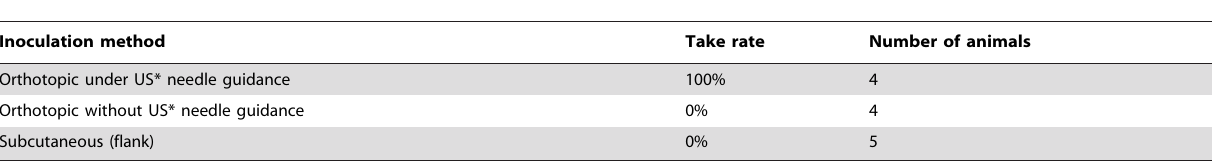
Table 1. Success of establishing LM2 tumor xenografts in nude rats.